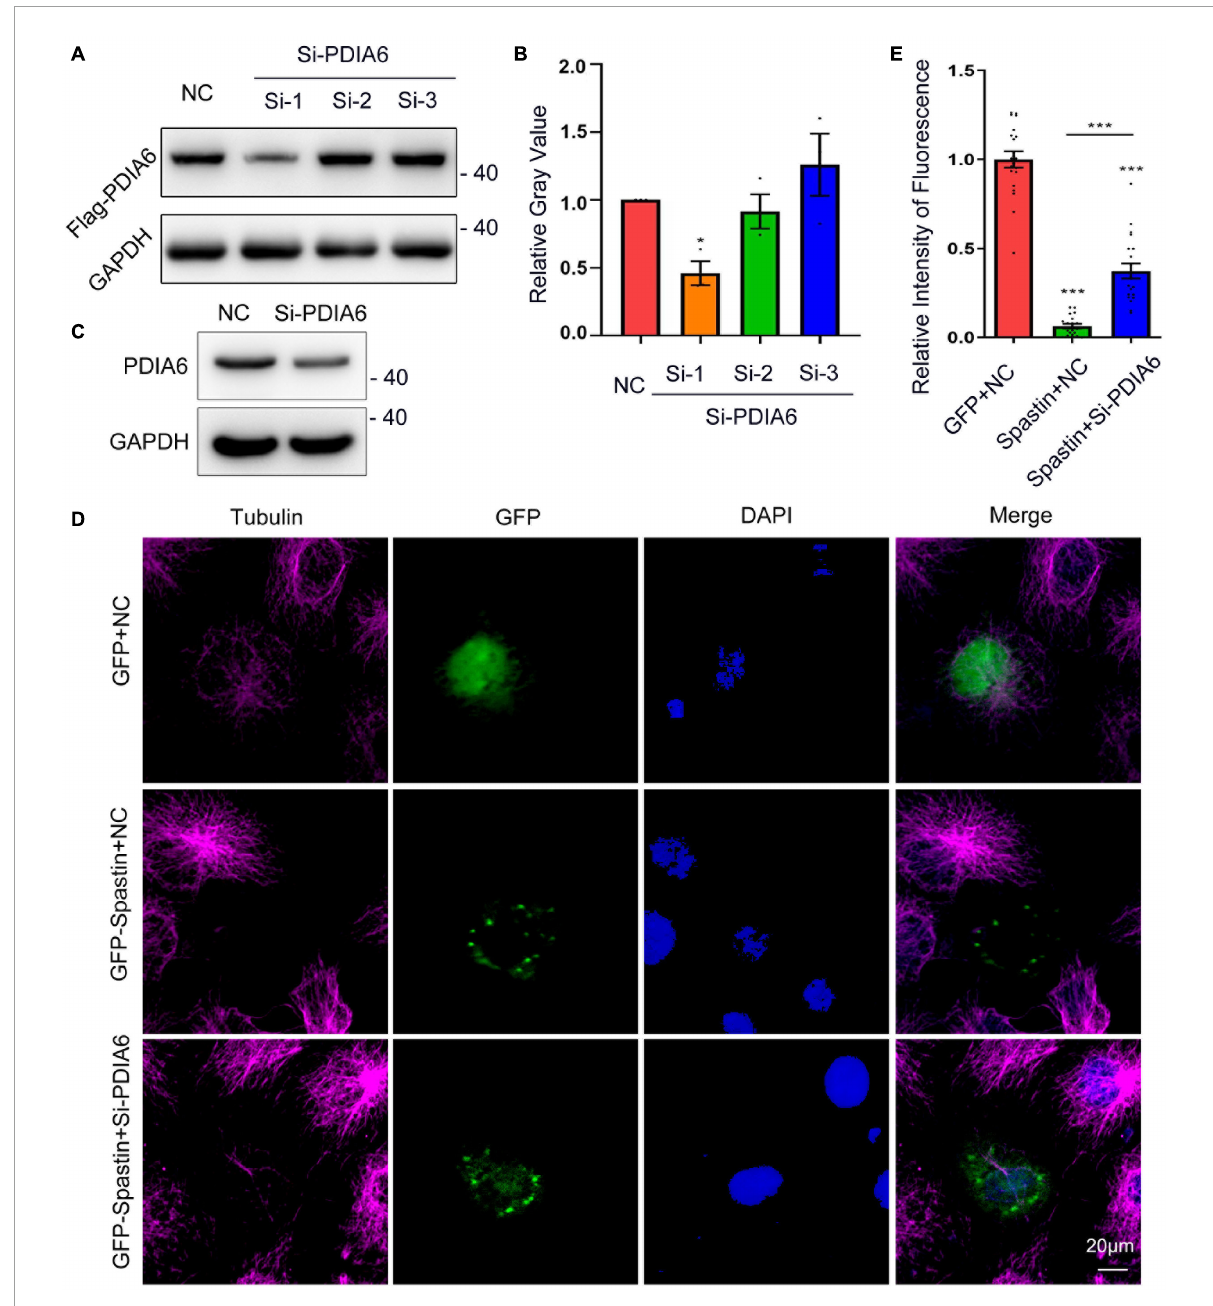
FIGURE4 PDIA6 and spastin cooperate to control intracellular microtubule dynamics. (A) The efficiency of siRNA-mediated PDIA6 knockdown was examined in COS-7 cells that were co-transfected with three different siRNAs (Si-1, Si-2, or Si-3) and the Flag-PDIA6 plasmid. Anti-Flag was then used for Western immunoblotting, with GAPDH serving as a loading control. (B) Relative PDIA6 expression. (C) COS-7 cells were transfected using PDIA6 siRNA-1, after which endogenous PDIA6 expression was analyzed. (D) Microtubules were detected in COS-7 cells following spastin and Si-PDIA6 transfection; GFP (green), tubulin (Pink), DAPI (blue). Spastin severed microtubules within these cells, whereas the knockdown of PDIA6 disrupted this spastin-mediated severing of microtubules. (E) Relative to control cells, those in which PDIA6 was knocked down exhibited significantly reduced spastin fluorescent intensity ( n = 20/group). * P < 0.05, ** P < 0.01, *** P <